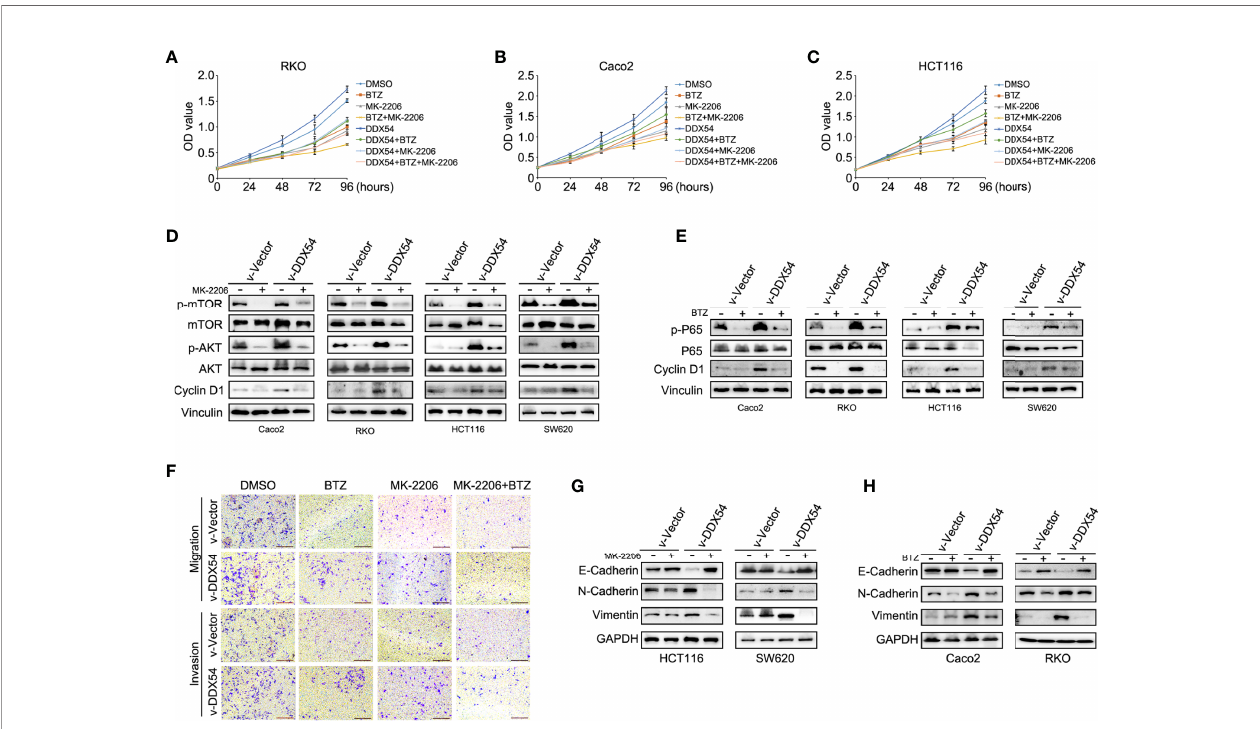
FIGURE 6 | Inhibition of NF- k b and AKT/mTOR pathway weakened the carcinogenic effects of CRC cells by DDX54. (A – C) BTZ (Bortezomib, 2 nM) and MK2206 (1 m M) (inhibitor of NF- k b and AKT pathway respectively, Selleck) repressed the proliferative role of DDX54 on CRC cells. (D, E) The phosphorylation level of P65 and AKT was determined in CRC cells with different treatments of DDX54 and inhibitors. (F) The metastasis ability was weakened by inhibitors. (G, H) EMT markers were detected in CRC cells with DDX54 and inhibitor